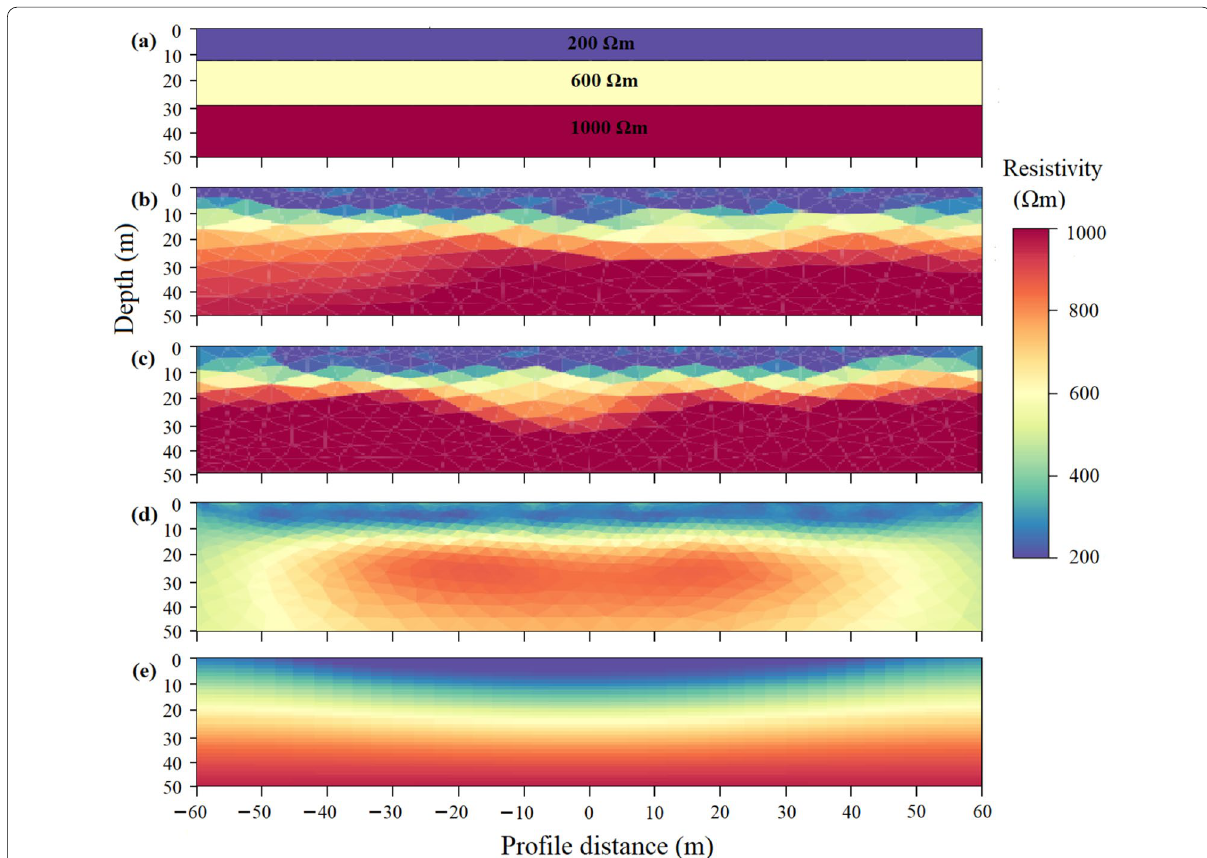
Fig. 8 a The layered conceptual model consists of sand, gravel, and moderately fractured sandstone from top to bottom. The inverted model results for the inversion freeware: b pyGIMLi, c BERT, d ResIPy, and e SimPEG. Unstructured triangular mesh is implemented in pyGIMLi, BERT, and ResIPy, whereas tensor mesh is used in